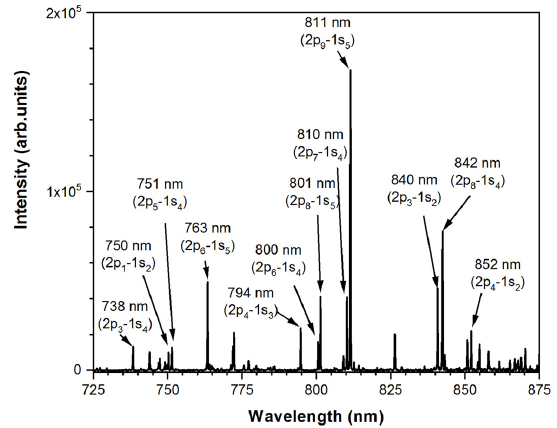
Figure 2. Typical optical emission spectrum of the argon plasma examined in this